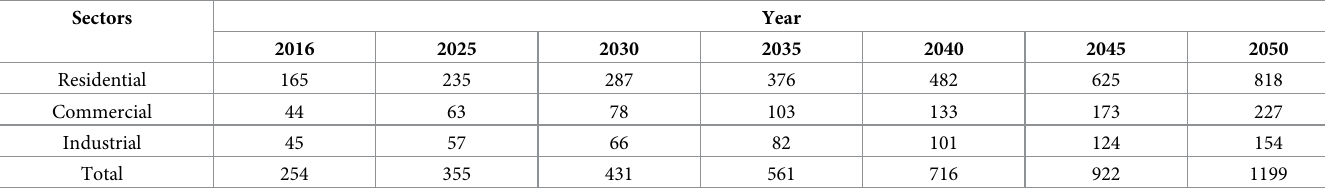
Table 7. Predicted the water demand (MCM).